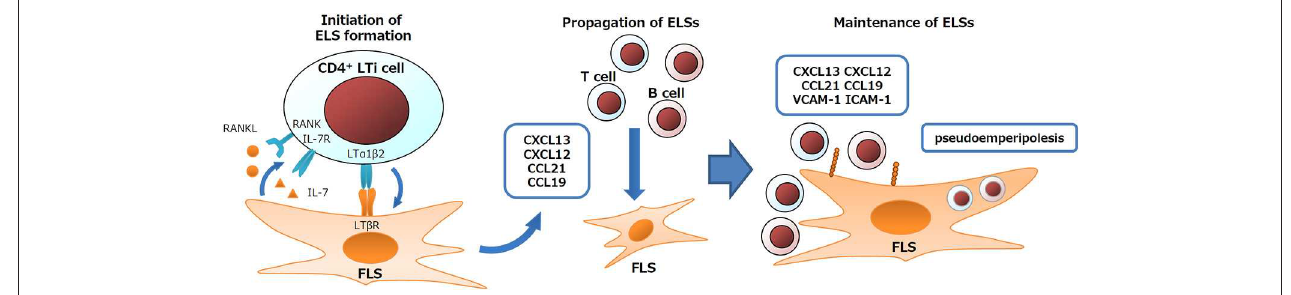
FIGURE 2 | Schematic outline of FLS contribution to TLO